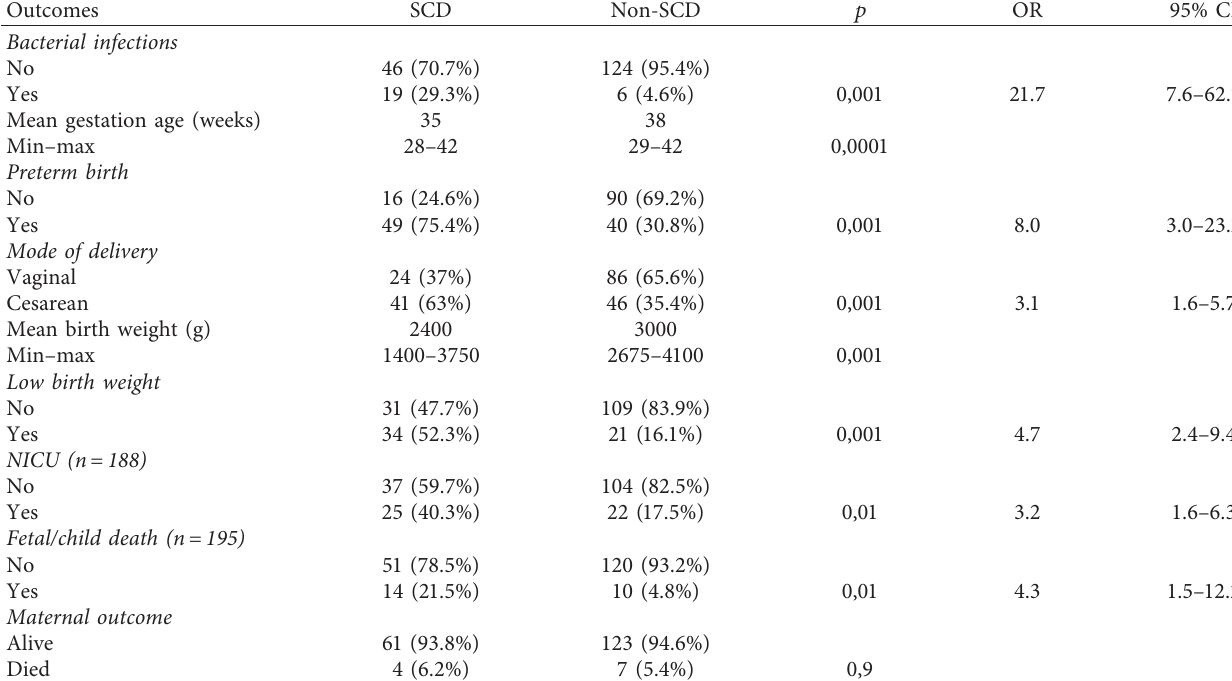
Table 2: Comparison of perinatal characteristics and the outcome of pregnancy between SCD women and non-SCD women seen in 4 maternity hospitals in Brazzaville between July 2017 and June